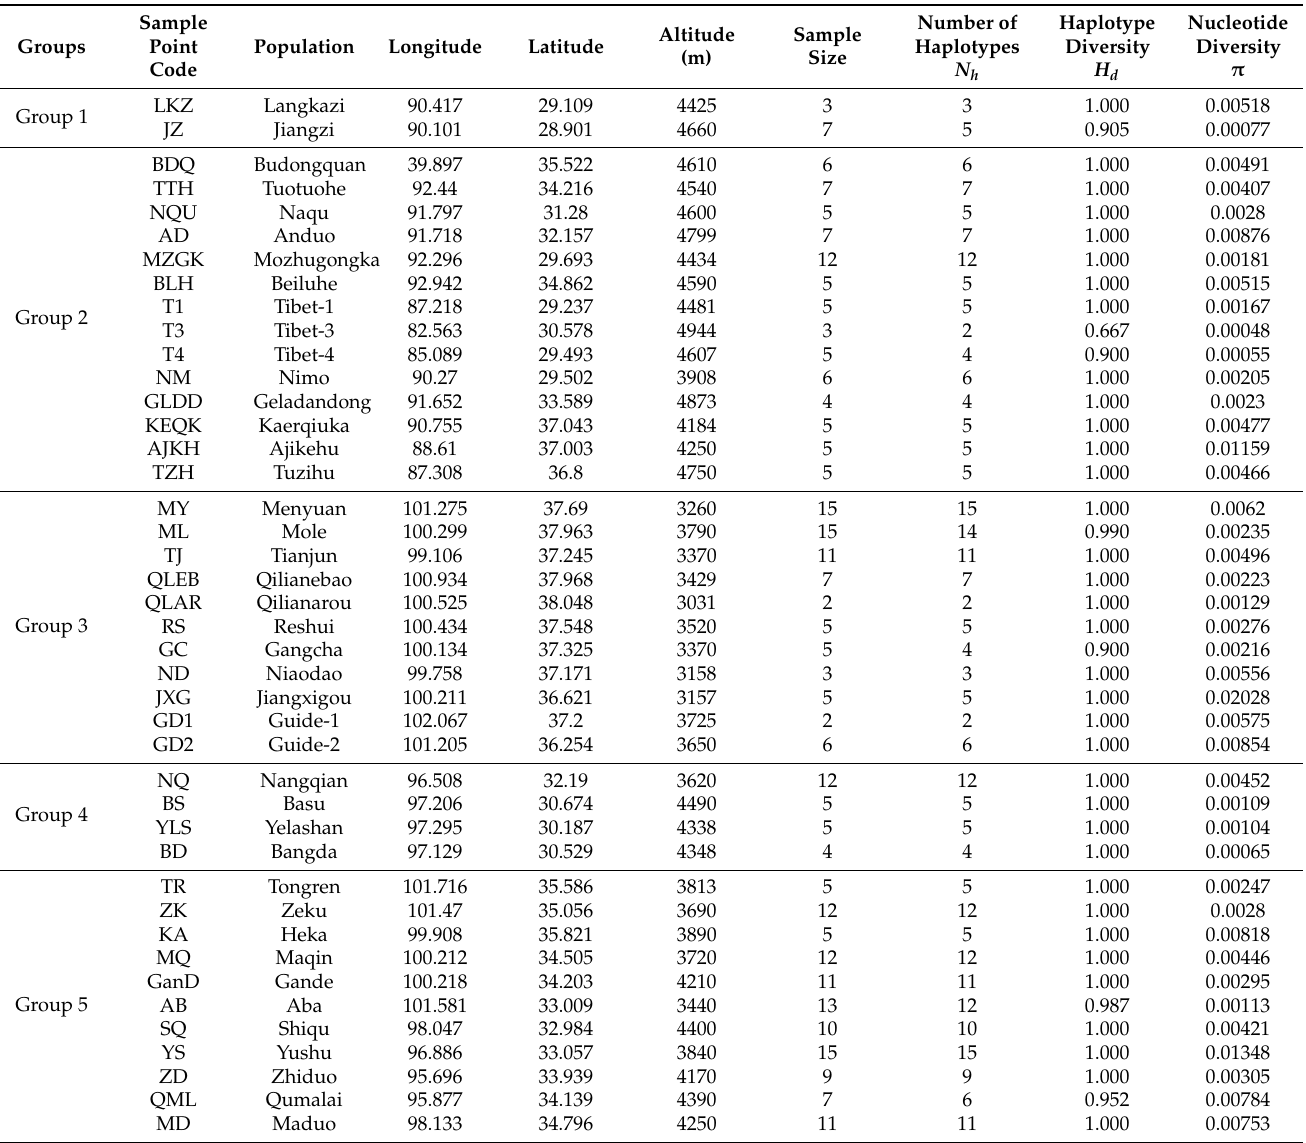
Table 1. Sampling information and genetic parameters based on the combined dataset ( Cytb + COI